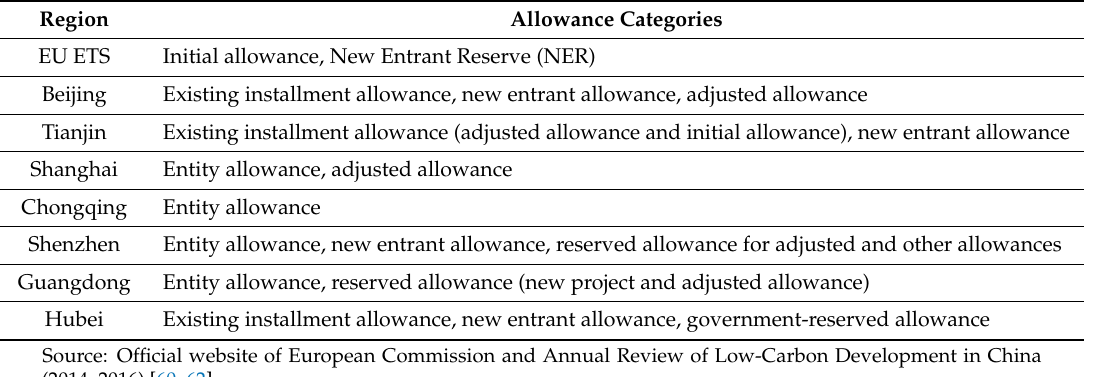
Table 4. Allowance categories in EU ETS and China’s pilot ETS.